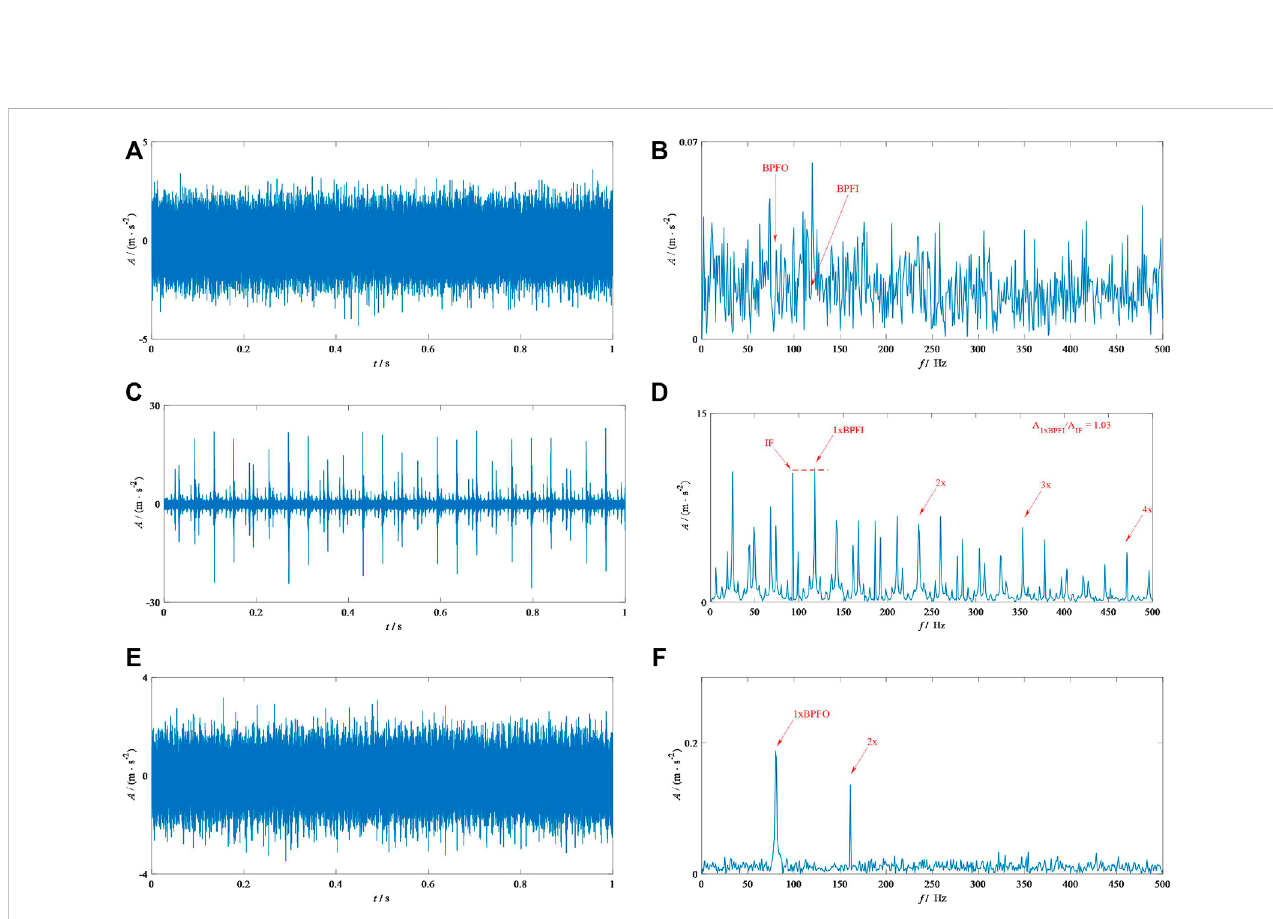
FIGURE 5 Signals from MFPT: (A) and (B) correspond to the TDW and SES of the healthy bearing, (C) and (D) correspond to the TDW and SES of the inner race fault bearing, and (E) and (F) correspond to the TDW and SES of the outer race fault bearing.